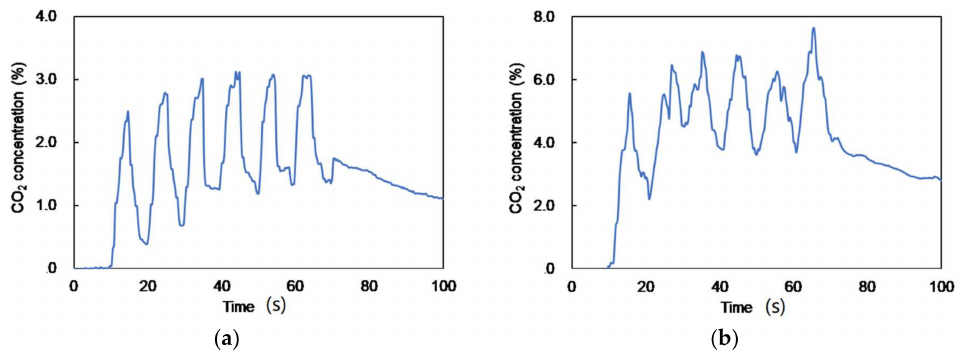
Figure 10. Results of real-time measurement of CO 2 concentration in human breath: ( a ) measured at rest and ( b ) measured after exercise.